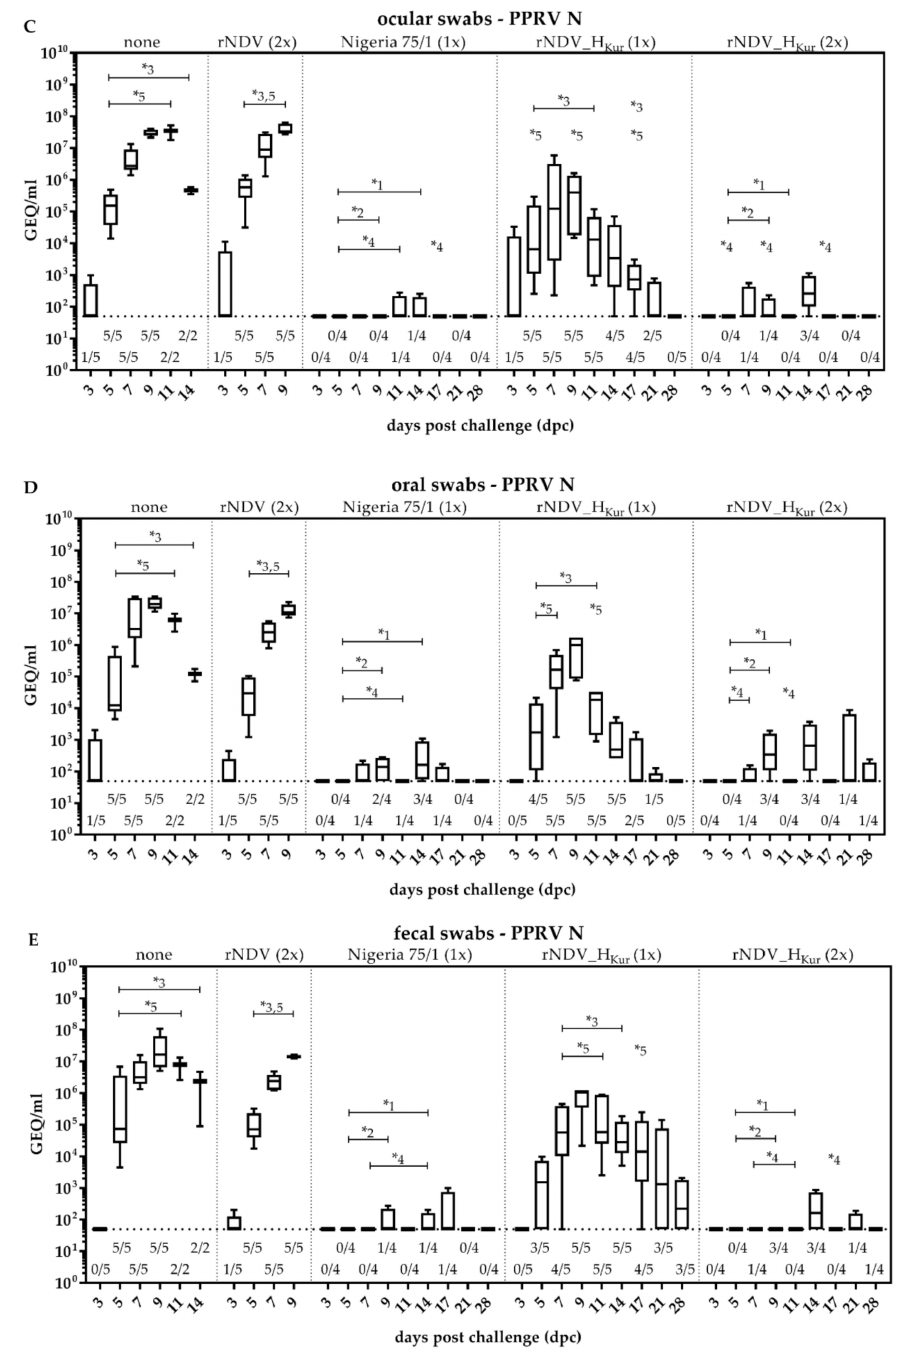
Figure 7. Virus dissemination and shedding after PPRV challenge infection. Five goats each were either left unvaccinated (group 1), double inoculated with rNDV (group 2), single vaccinated with PPRV Nigeria 75 / 1 (group 3), single vaccinated with rNDV_H Kur (group 4), or double vaccinated with rNDV_H Kur (group 5). All goats were infected with PPRV Kurdistan / 11 three weeks after immunization. ( A ) Blood, ( B ) nasal swabs, ( C ) ocular swabs, ( D ) oral swabs, and ( E ) fecal swabs were taken at indicated days after challenge infection (dpc) and analyzed by quantitative real-time RT-PCR (RT-qPCR) for the presence of PPRV N specific RNA. Values were transformed to genome equivalents (GEQ) using calibration curves of defined RNA standards that were included within each RT-qPCR run. The number of positive samples relating to the total number of samples tested by RT-qPCR is given below the boxplot. Asterisks (*) and numbers above datasets indicate significant di ff erences ( α = 0.05) between respective groups at the same